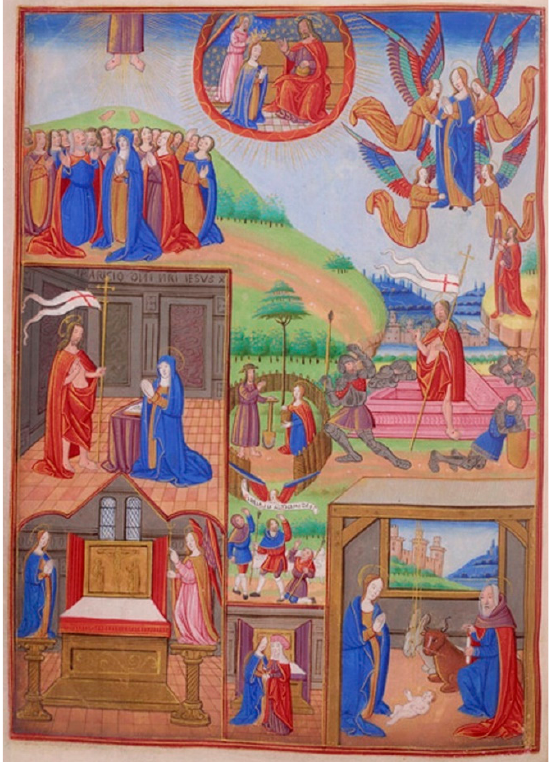
Figure 6. Pictorial cycle f.53v of the Hours of Thomas Butler, © British Library Board.